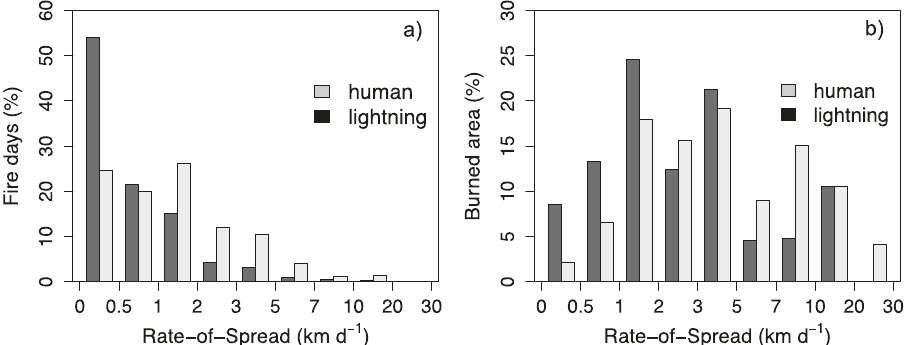
Fig. 2 Frequency distribution of daily fi re rate-of-spread. Percentage of fi re days with a given fi re spread rate ( a ) and percentage of burned area with a given fi re spread rate ( b ), as a function of fi re type. A fi re day is a day on which active fi re detections were present for a given fi re. Fire spread rate is de fi ned as the 95th percentile of the spread rate over all active fi re detections on the fi re line. The mean daily rate-of-spread is 1.83 km day − 1 for the human-caused fi res and 0.84 km day − 1 for lightning-caused fi res shown in panel a . Similarly, mean rate-of-spread normalized by burned area (shown in panel b ) is 5.6 km day − 1 for the human-caused fi res and 3.5 km day – 1 for lightning-caused fi res. The frequency distributions of daily rate-of-spread between human and lightning-caused fi res as a function of fi re day or burned area are signi fi cantly